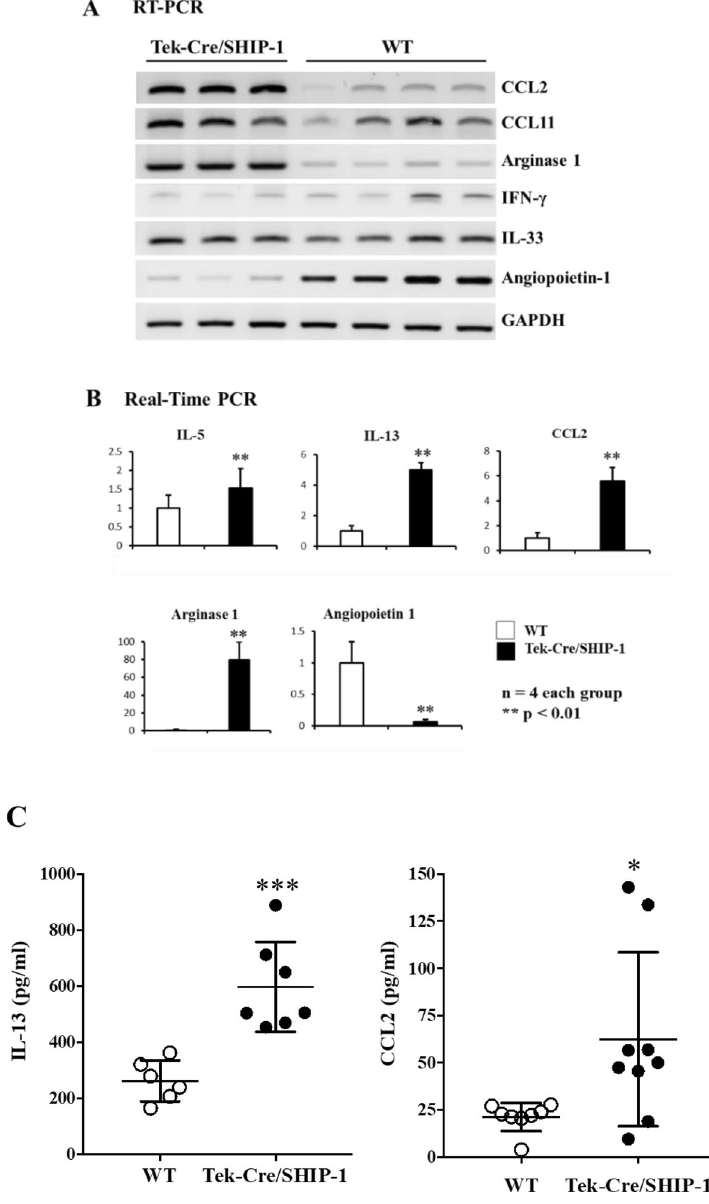
Figure 7. Altered expression of cytokines, chemokines, and factors in the lung. ( A ) RT-PCR analysis of total lung RNA from WT and Tek-Cre/SHIP-1 mice using gene-specific primers is shown. Amplified products were analyzed by electrophoresis. (n = 3–4) ( B ) Real-time quantitative PCR analysis of cytokine and chemokine expression using the double delta method (ΔΔC) (n = 4 for each group) ( **p < 0.01 vs. WT ) . (C) ELISA measurement of IL-13 and CCL2 proteins in the BAL fluid samples (n = 6–9) ( *p < 0.05, ***p < 0.001 vs. WT )